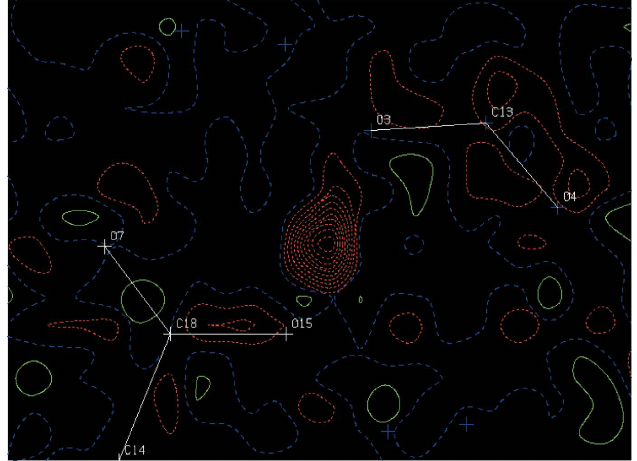
Figure 6 A difference scattering density map for the 298 K structure without the H atom between O15 and O3. The red dotted lines and green solid lines show negative and positive density distribution, respectively. A nuclear density distribution with a large ellipticity along the bond path between O15 and O3 is